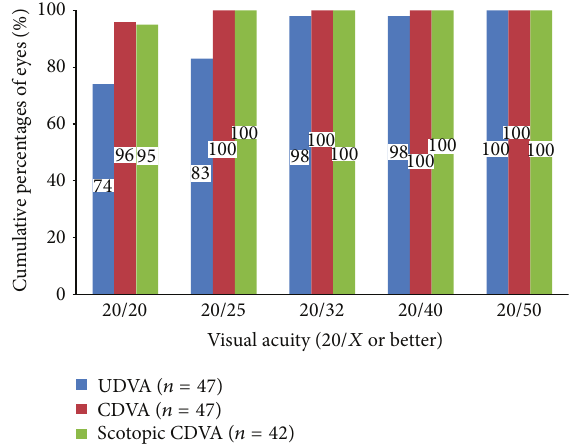
Figure 1: Monocular uncorrected distance visual acuity (UDVA), corrected distance VA (CDVA), and scotopic CDVA at 6 months.